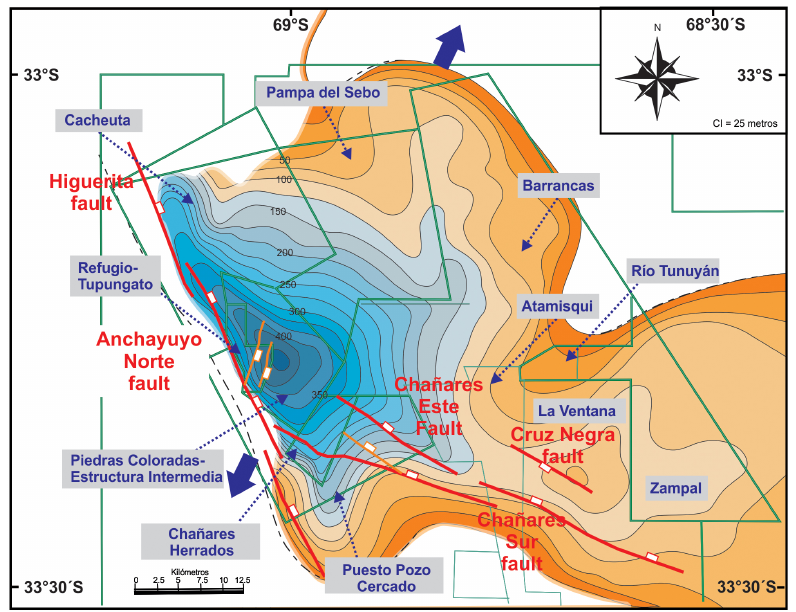
Figure 3. Thickness map of the Cacheuta Formation (Triassic lake deposits representing the climax of synrift) modified from Jones (1992). Notice the Anchayuyo Norte fault corresponds to the maximum thicknesses of this unit. Blue arrows represent the direction of extension during the Triassic (after Giambiagi et al., 2011). Green polygons are oil field areas (names in blue) covered with 3-D seismic